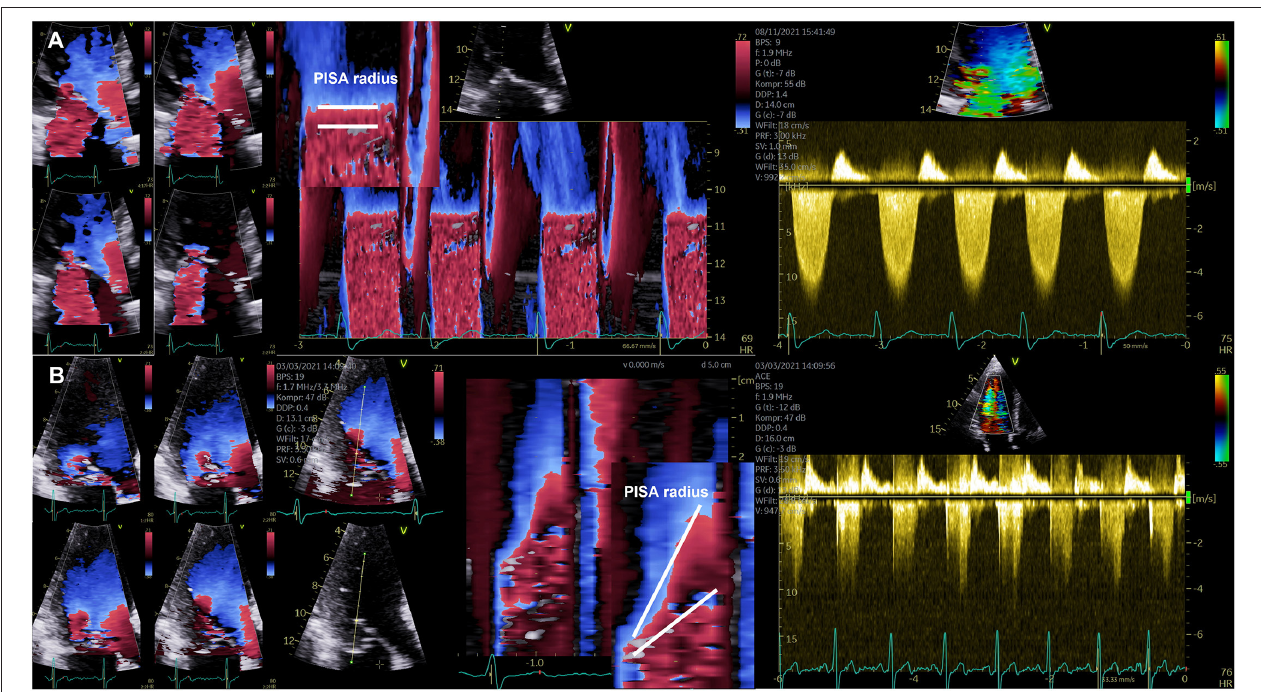
FIGURE 3 | Illustration of the dynamics of the PISA radius in mitral regurgitation (MR). (A) Documentation of almost stable PISA radius in a patient with secondary MR. On the left side four consecutive images during systole are shown illustrating the almost constant PISA radius. Right to these images a color-coded M-Mode illustrating the horizontal PISA radius and the continuous wave Doppler spectrum are shown. (B) Documentation of severe late systolic increase of PISA radius in a patient with primary MR. On the left side four consecutive images during systole are shown illustrating the significant increase of PISA radius at late systole. Right to these images a color-coded M-Mode illustrating the dynamics of the PISA radius and the continuous wave Doppler spectrum with the late time-to-peak regurgitant flow velocities are